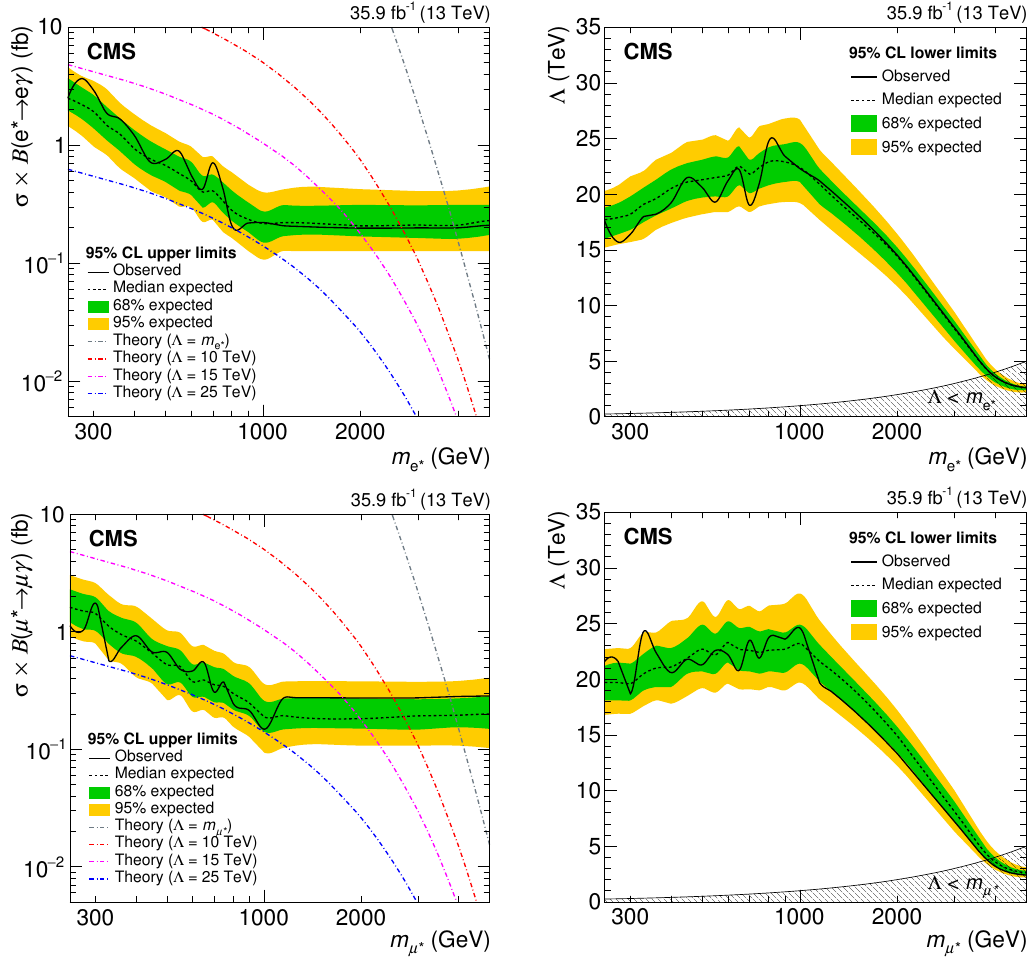
Figure 6 . Observed (solid) and expected (dashed) 95% CL upper limits on the product of the production cross section and branching fraction (left column) and lower limits on the compositeness scale (right column) as a function of signal mass m ‘ (cid:3) , together with the 68% (green, inner) and 95% (yellow, outer) quantiles of the expected limit, for e (cid:3) (upper row) and (cid:22) (cid:3) (lower